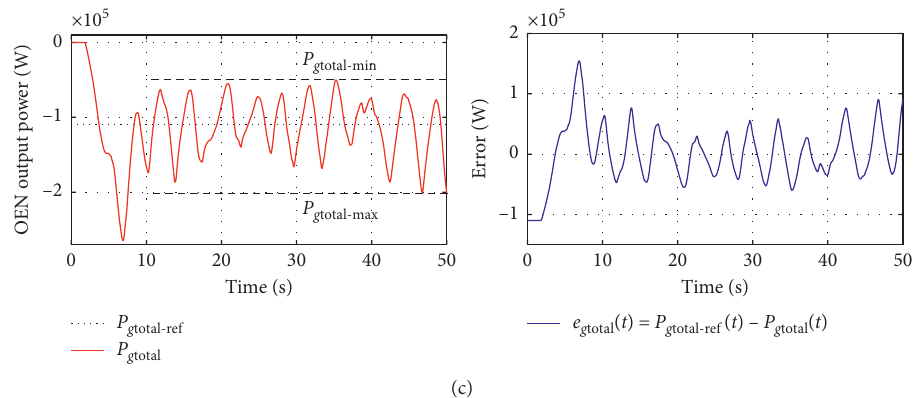
Figure 14: OEN output power and error waveforms with communication delay. (a) τ � 100ms. (b) τ � 500ms. (c) τ �